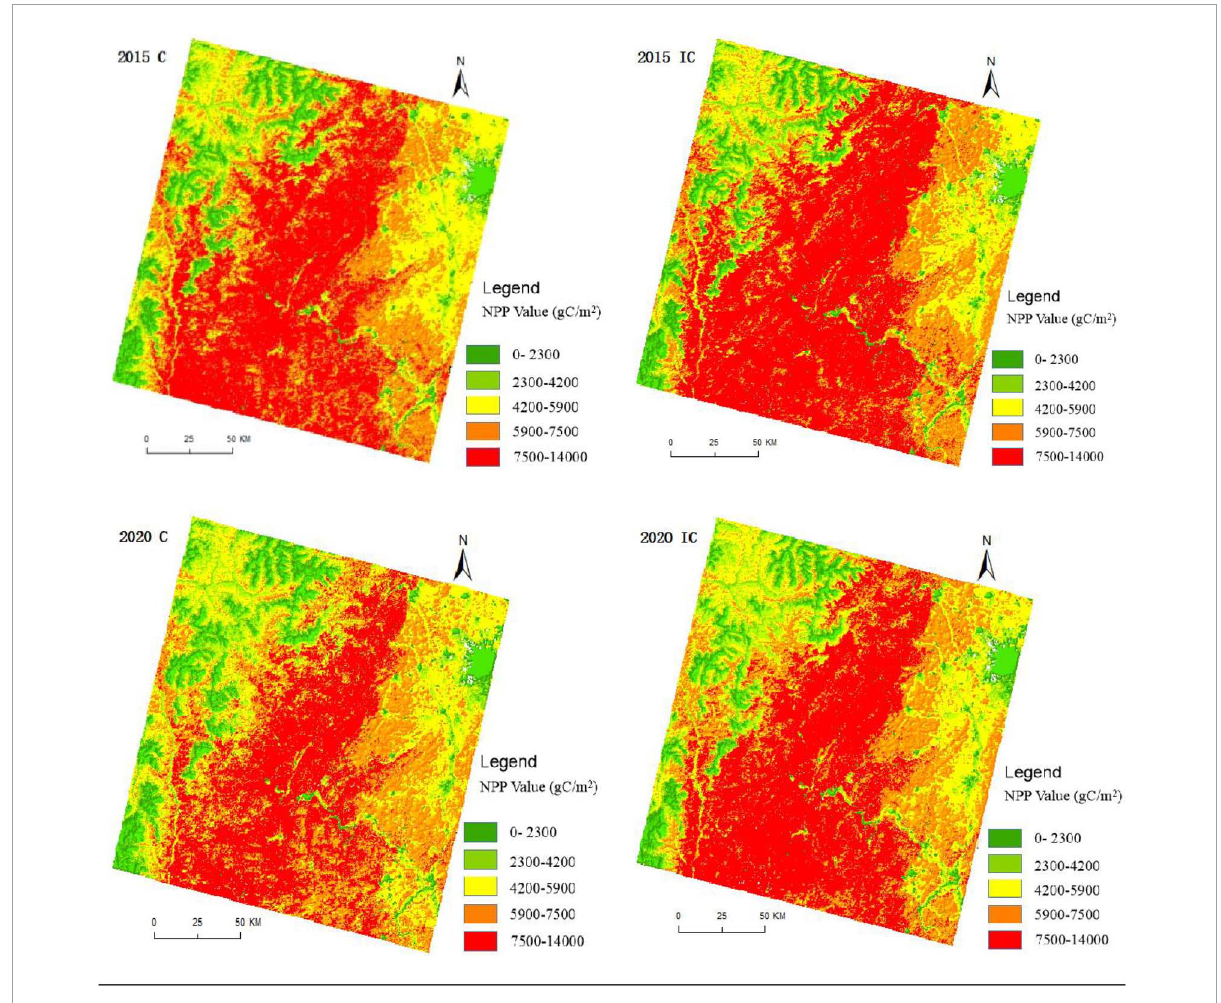
FIGURE7 Improved CASA model and CASA model estimation results